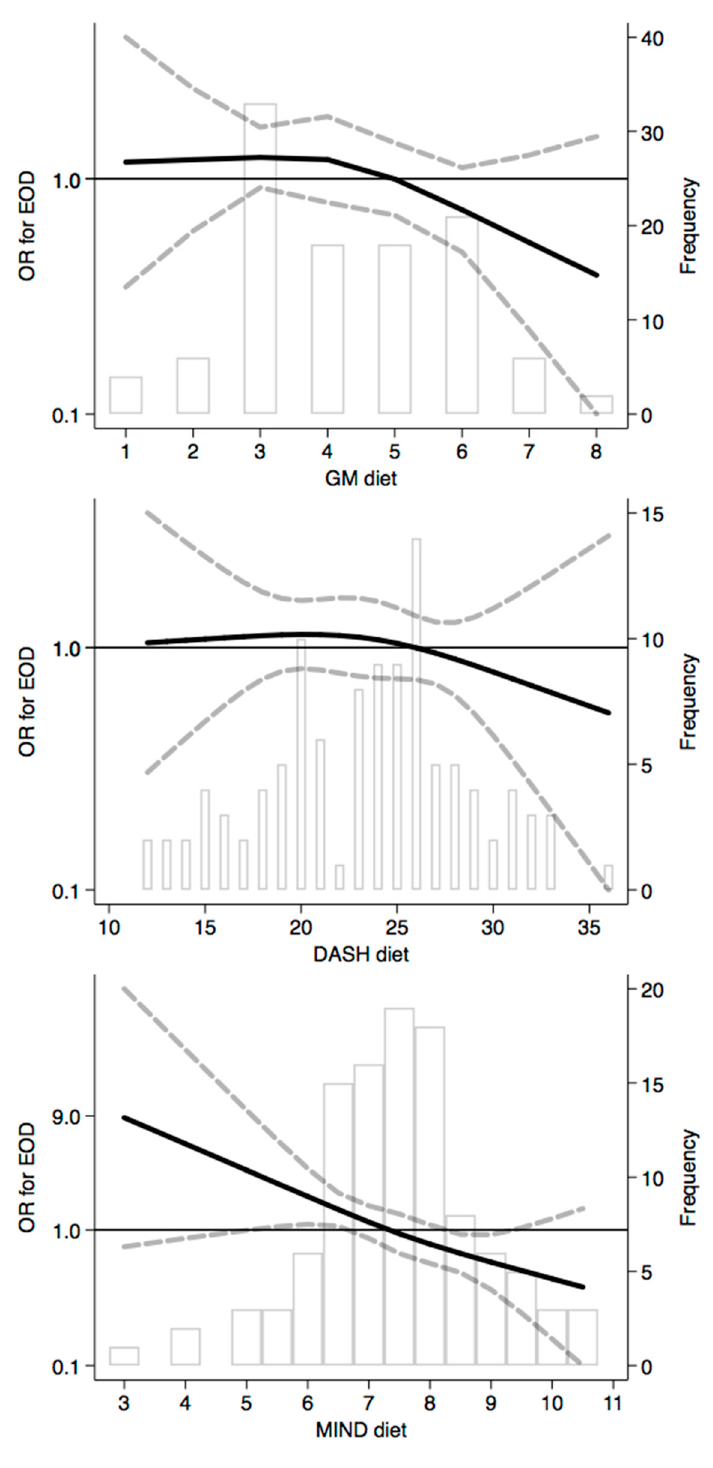
Figure 11. Spline regression analysis for dietary patterns. Greek-Mediterranean (GM) diet, Dietary Approaches to Stop Hypertension (DASH) diet, and Mediterranean-DASH Intervention for Neurodegenerative Delay (MIND) diet. The black line indicates odds ratios for dementia risk; dash gray lines are 95% confidence limits; the reference line at 1.0 with gray bars shows the dietary-pattern score distribution.